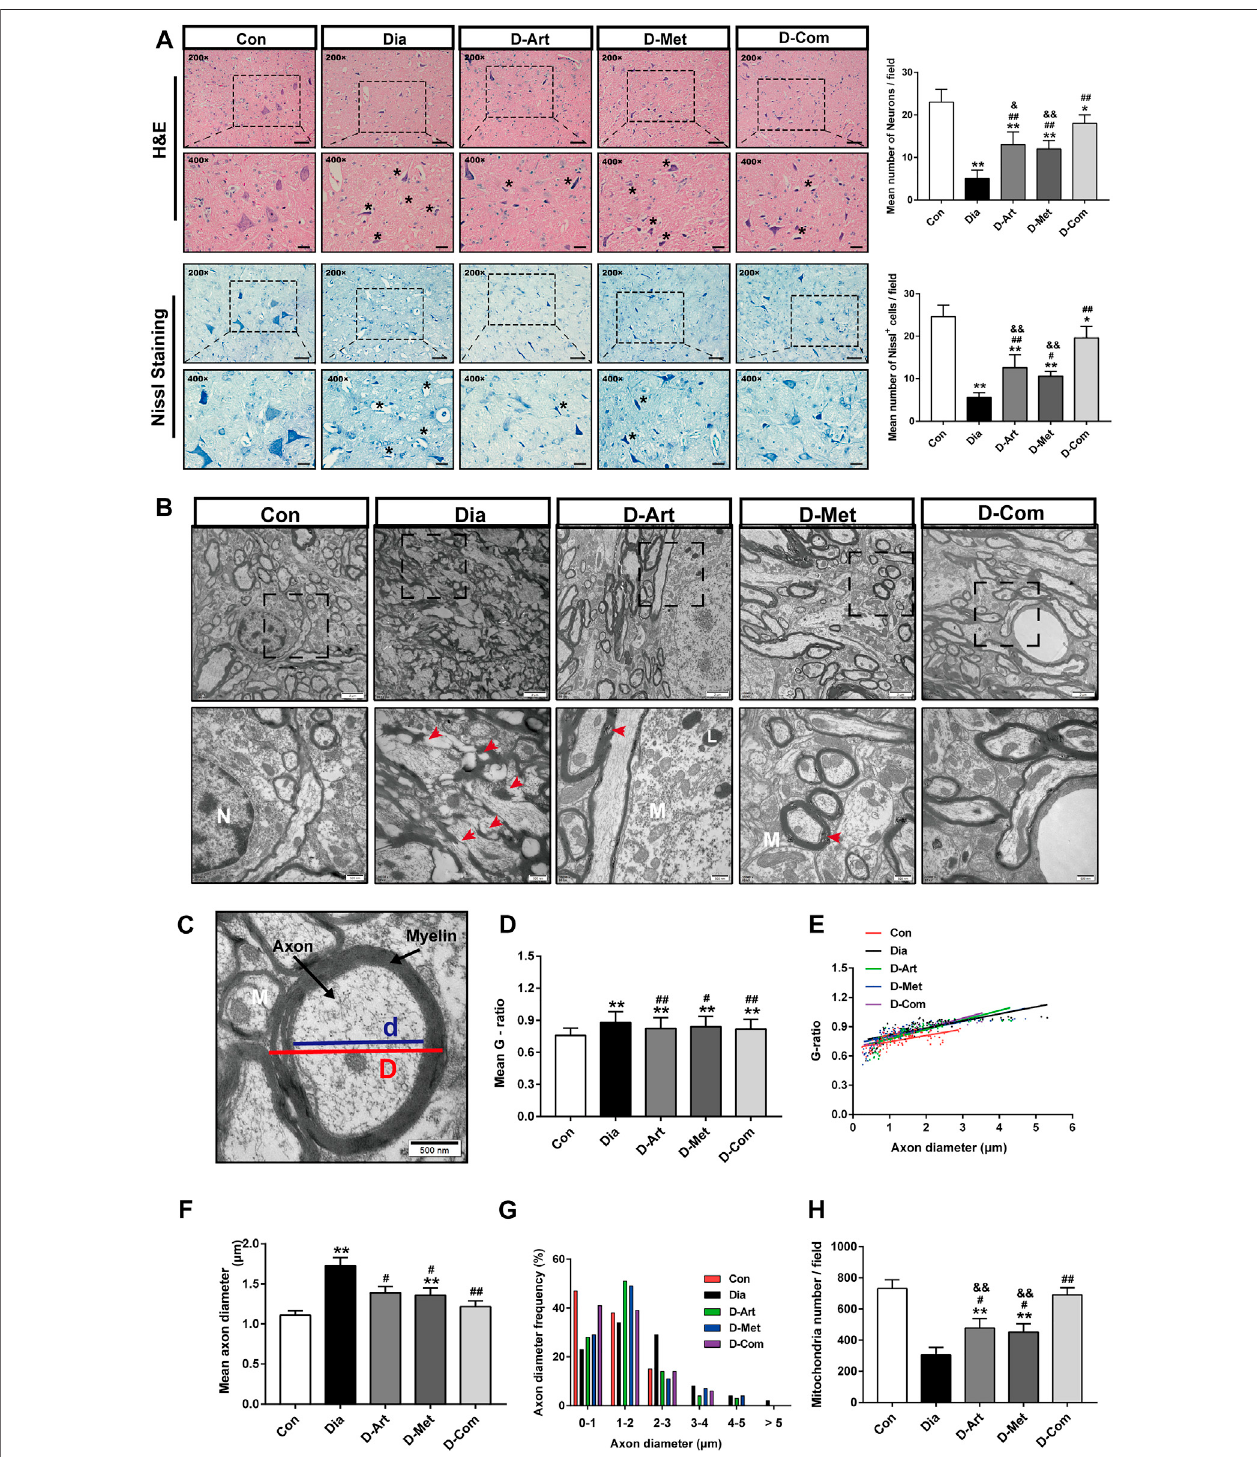
FIGURE 5 | ART or Met alone and ART/Met combination alleviate central SSN injury in the T2DM rats. (A) H&E and Nissl staining of SSN in each group (5 rats per group),scalebar (cid:1) 50 μ m(200 × );scalebar (cid:1) 20 μ m(400 × ).Crumpledandvacuolatedneuronswerelabeledusingblack*. (B) UltrastructureofSSNineachgroup(3rats per group). N, nucleus; L, Lysosome; M, mitochondria. Red arrows represent damaged and disrupted myelin. (C) Schematic diagram of G-ratio. (D – H) The mean g-ratios, individual g-ratios distribution, axonal diameters, and distributions of axonal diameters, and mitochondria number in different groups. SSN, superior salivatorynucleus;Dataareexpressedasthemean ± SD.* p < 0.05and** p < 0.01versusCongroup;# p < 0.05,## p < 0.01versusDiagroup;& p < 0.01and&& p < 0.01 versus D-Com group. Con, Normal control group; Dia, Untreated diabetic group; D-Art, ART-treated diabetic group; D-Met, Met-treated diabetic group; D-Com, ART/ Met co-treated diabetic